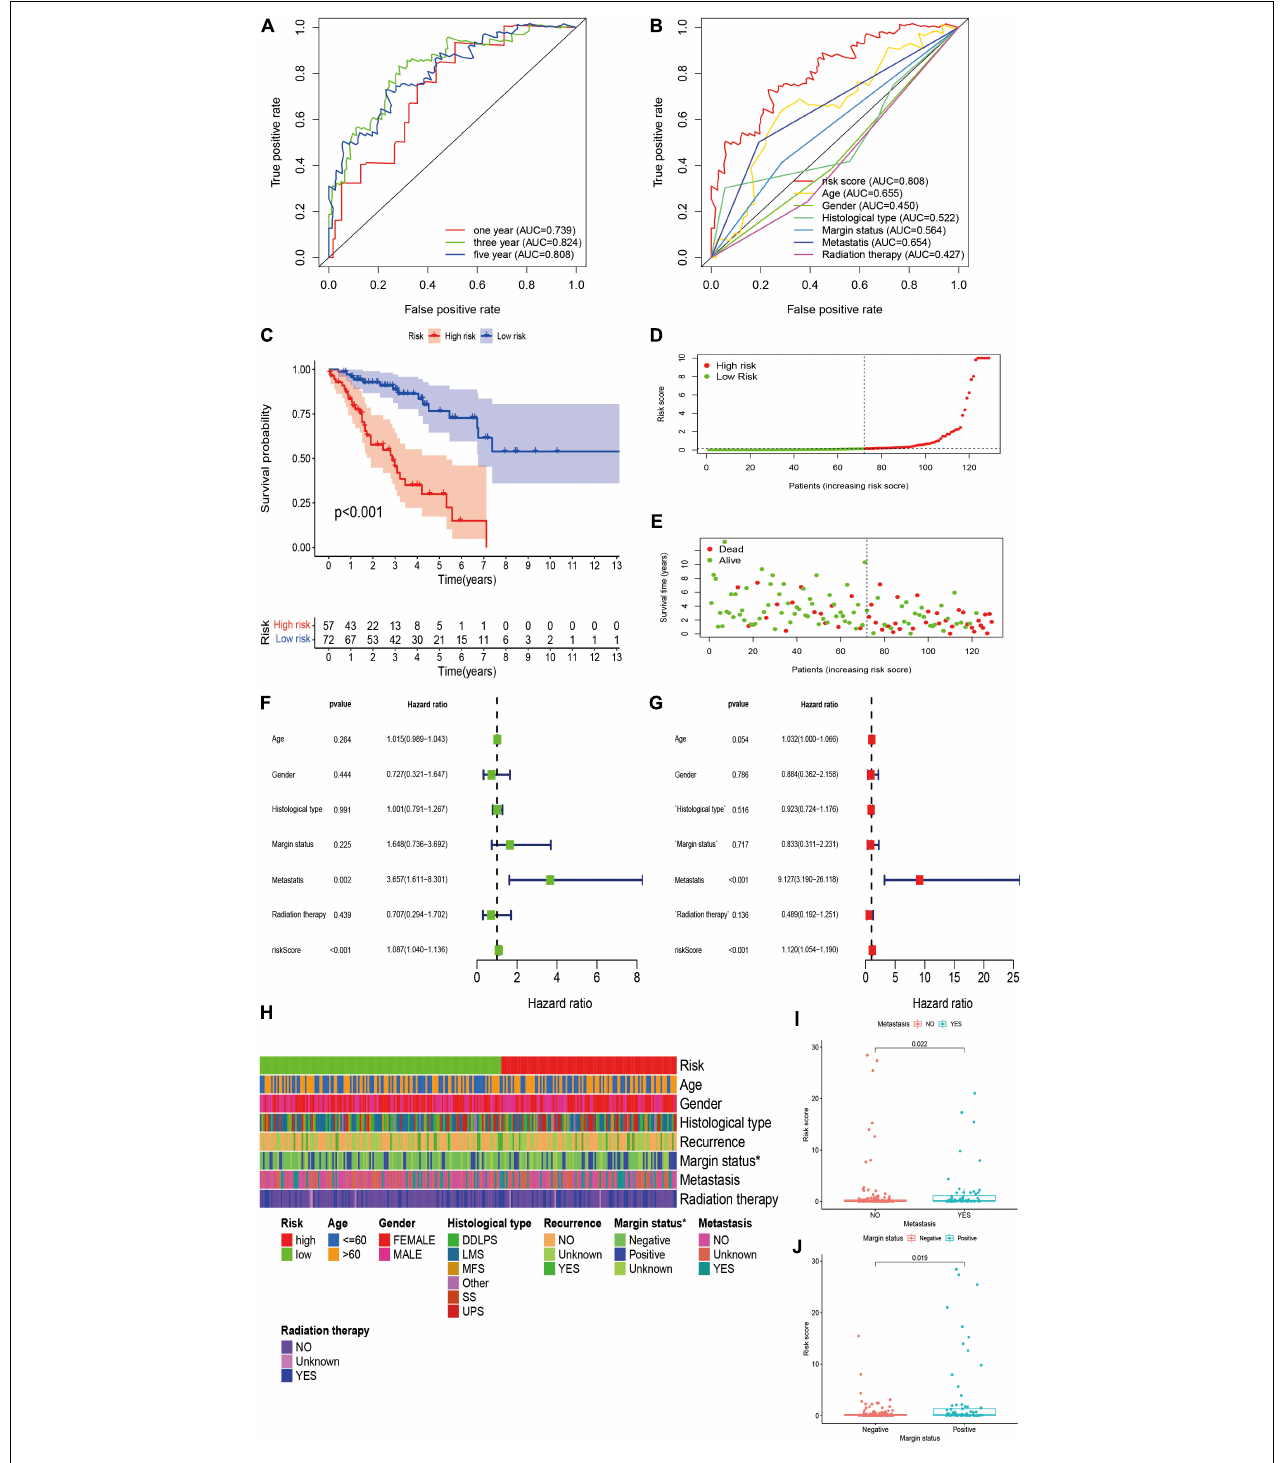
FIGURE 4 | Validation and clinical evaluation of the irlncRNA-based risk signature. (A) The 1-, 3-, and 5-year ROC curves of the risk signature in the validation cohort. (B) Comparison of the 5-year ROC curve with other clinical characteristics. (C) Kaplan–Meier analysis of patients in the high risk and low risk groups. Patients in the low-risk group experienced a longer survival time. (D,E) Distributions of risk scores and survival status of STS patients. (F,G) Univariate and multivariate Cox regression analyses of clinical factors and prognostic risk signature for overall survival. Univariate and multivariate analyses revealed that risk score was an independent prognostic predictor in the validation cohort. (H–J) Evaluation of the association between the risk signature and clinical parameters. A strip chart (H) along with the scatter diagram showed that (I) metastasis, and (J) margin status were significantly correlated with the risk score.